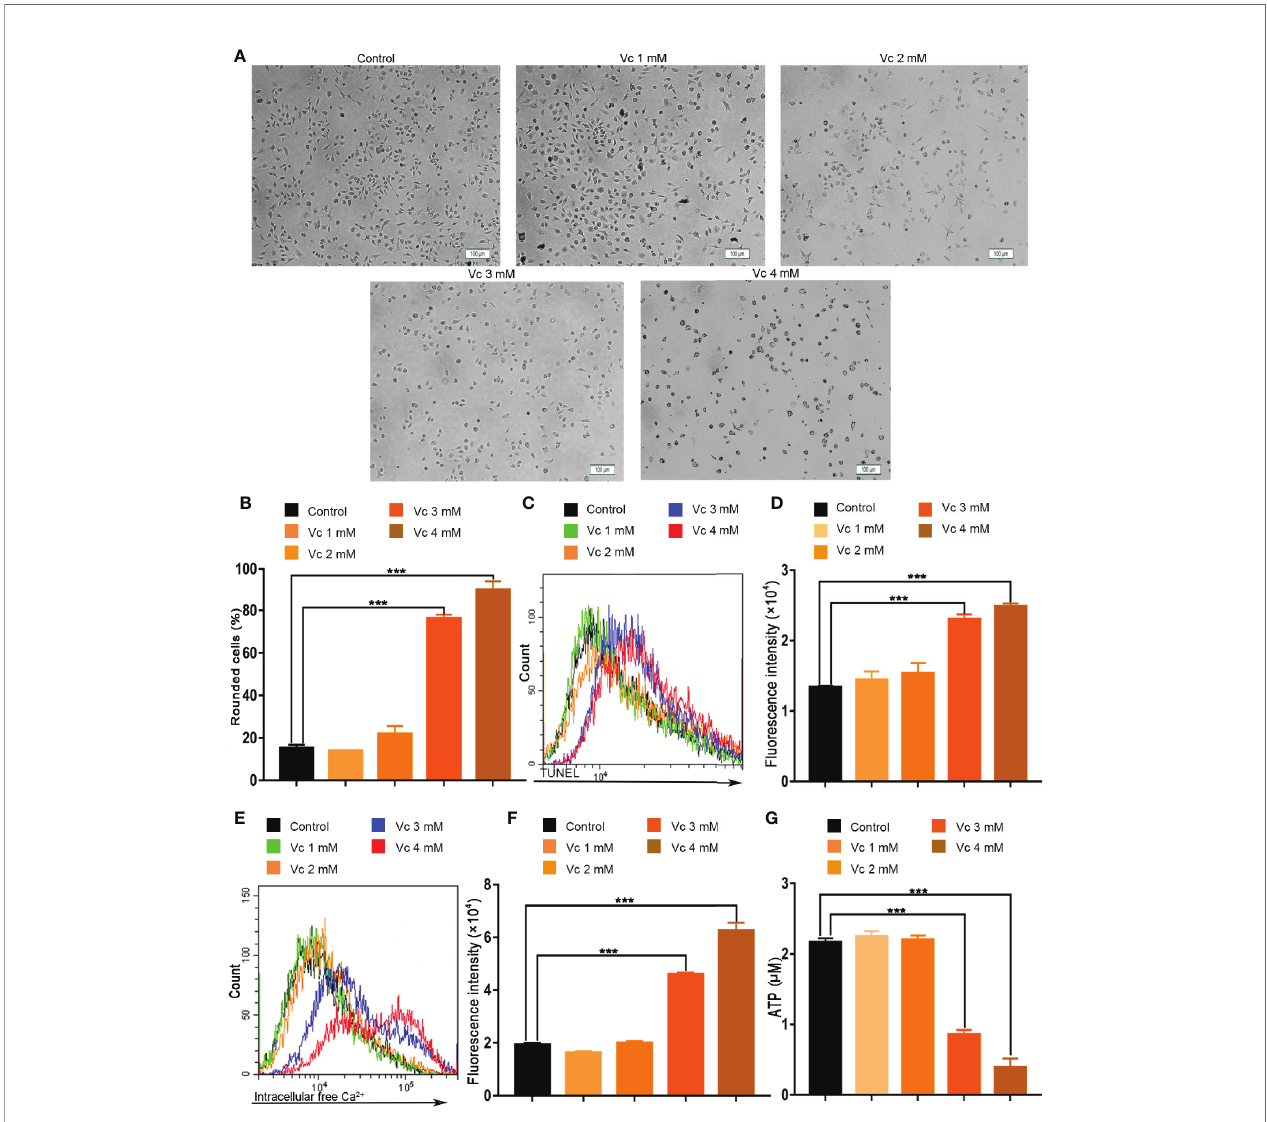
FIGURE 8 | Vitamin C causes apoptosis in macrophages. (A , B) Primary cultures of macrophages derived from bone marrow of mice. The bone marrow-derived macrophages (BMDMs) were treated with the different dose of vitamin C for 24 h. (A) The representative fi elds were photographed at 100× magni fi cation. (B) For quantitative analysis, the percentage of rounded cells was determined. (C) The fl uorescence pattern of terminal deoxynucleotidyl transferase-mediated dUTP nick end labeling (TUNEL) – stained BMDMs. (D) Cell associated mean fl uorescence intensities of TUNEL-stained BMDMs. (E) The fl uorescence pattern of Fluo-4/AM-stained BMDMs. (F) Cell associated mean fl uorescence intensities of Fluo-4/AM-stained BMDMs. (G) The levels of ATP in BMDMs. Data are mean ± SEM; n=3. ***p <